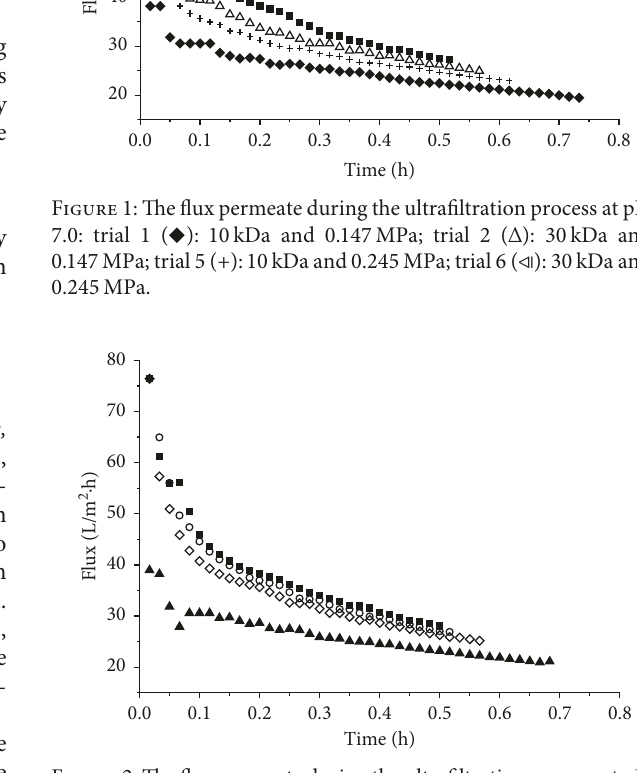
Figure 2: The flux permeate during the ultrafiltration process at pH 8.0: trial 3